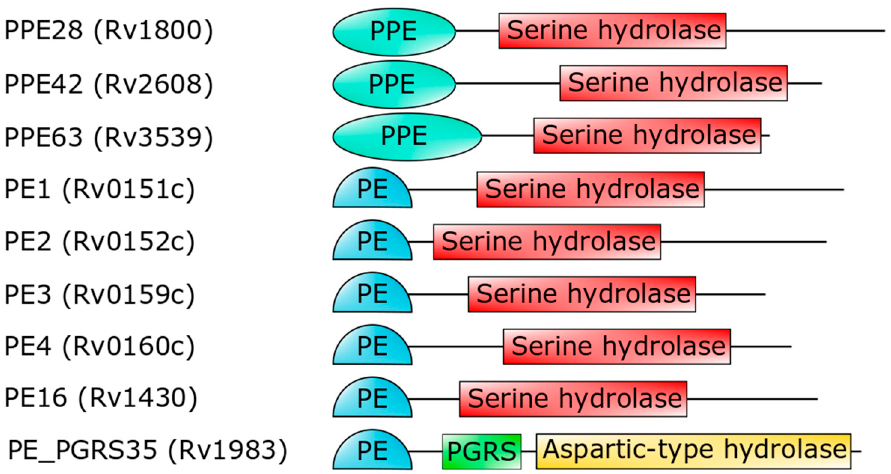
Figure 4. Domain architecture of PE- or PPE-containing Mtb proteins (strain H37Rv), which are predicted to embed a serine hydrolase domain [93]. The last hydrolase, PE_PGRS35, is the Mtb homolog of M. marinum PecA [92].